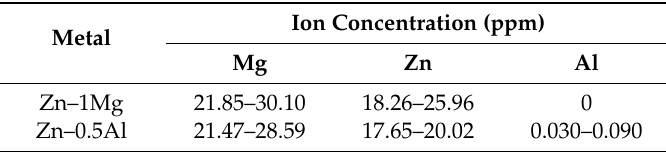
Table 1. Ion concentration of metal alloy extracts at IC 50